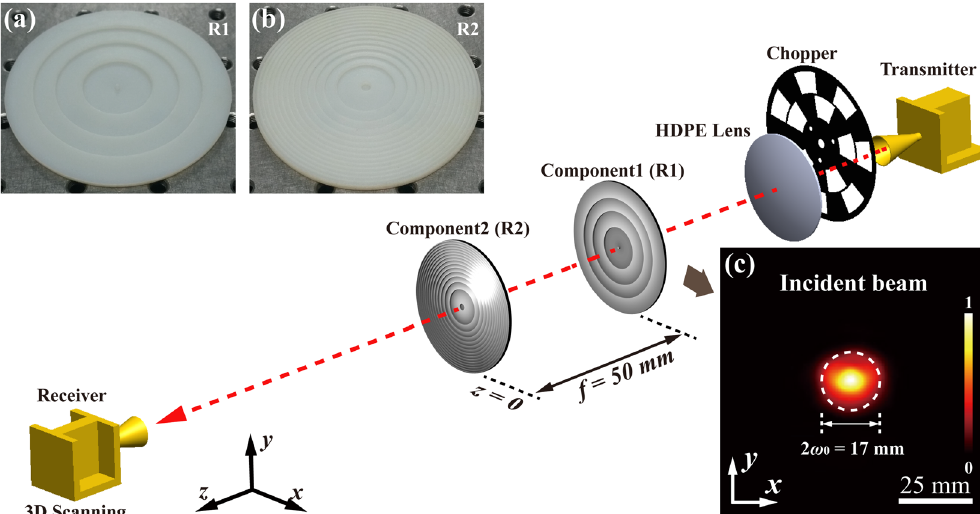
Figure 1. Schematic diagram of the experimental setup for generating THz CAVBs. Transmitter: A 0.3-THz radiation source coupled with a diagonal horn antenna. Chopper: Optical chopper. HDPE lens: High-density polyethylene lens. Receiver: Schotkky diode coupled with a diagonal horn antenna. Component1 (R1): the first phase plate; Component2 (R2): the second phase plate. ( a ) The 3D-printed R1 used in the experiment. ( b ) The 3D-printed R2. ( c ) The xy normalized intensity profile of the collimated Gaussian beam at the front plane of R1, showing a diameter of 17 mm (measured at FWHM, full width at half